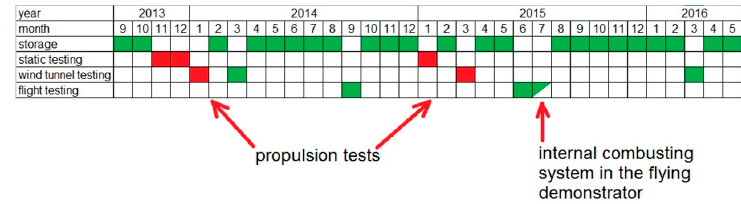
Figure 9. Schedule of batteries’ application in the research project.